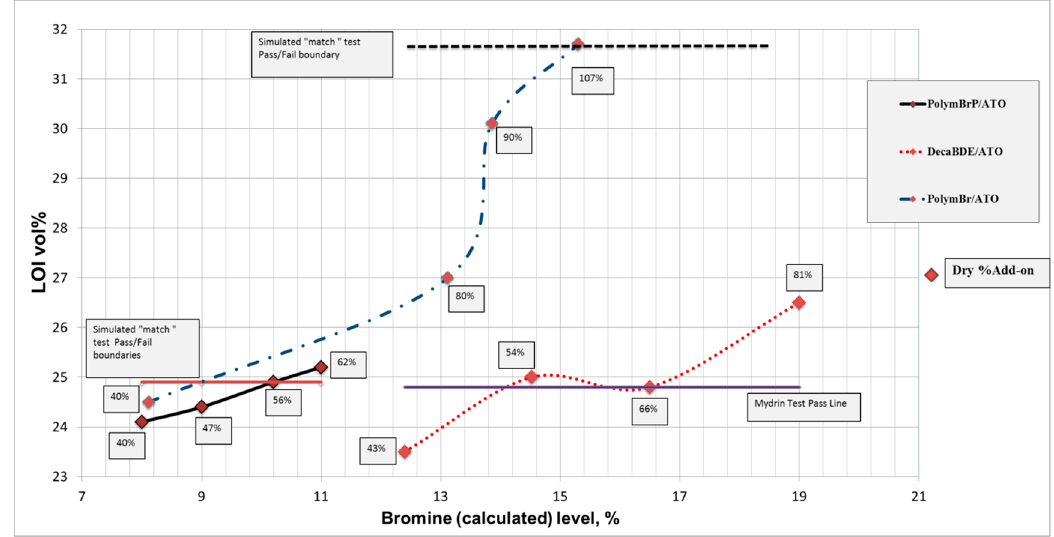
Figure 2. Effect of Bromine content on LOI values of DecaBDE/ATO, PolymBr/ATO and PolymBrP/ATO back-coated cotton fabrics with “match” test “pass/fail” boundaries indicated [45].